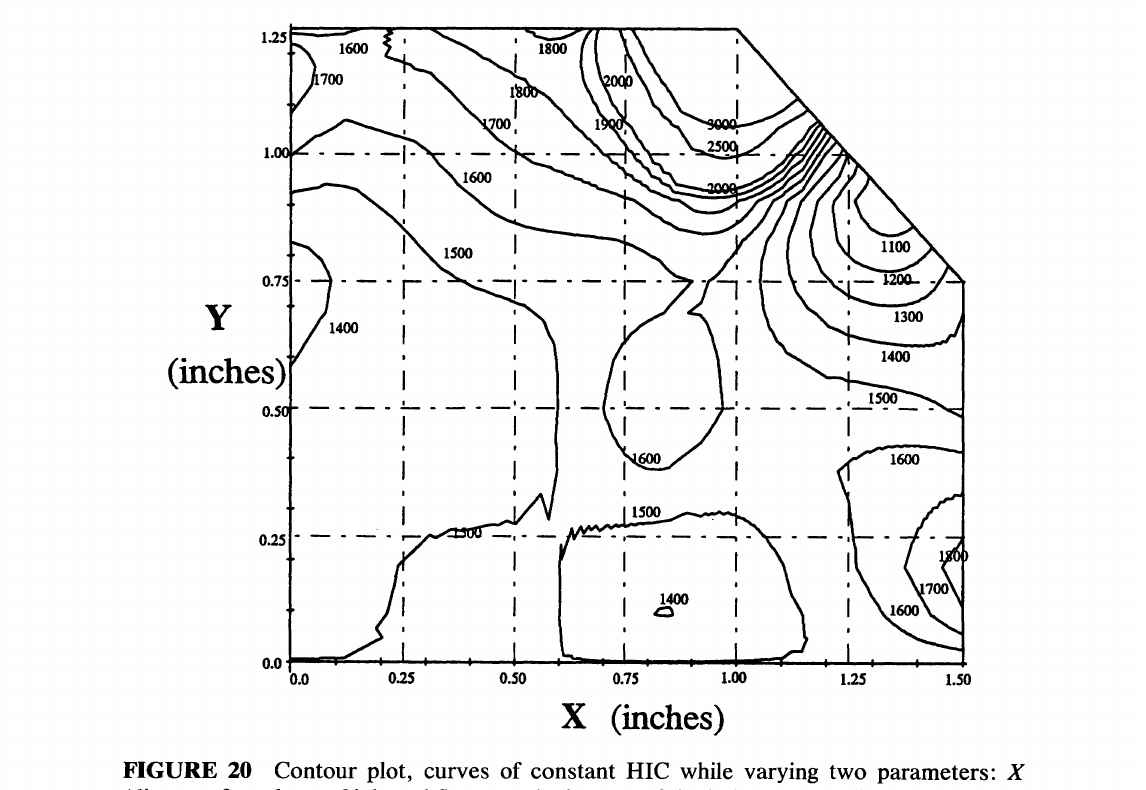
FIGURE 20 Contour plot, curves of constant HIC while varying two parameters: X (distance from base of inboard flange to the bottom of the hole) and Y (height of the hole). The parametric values for the optimal design are X = 1.35 in., Y = 0.09